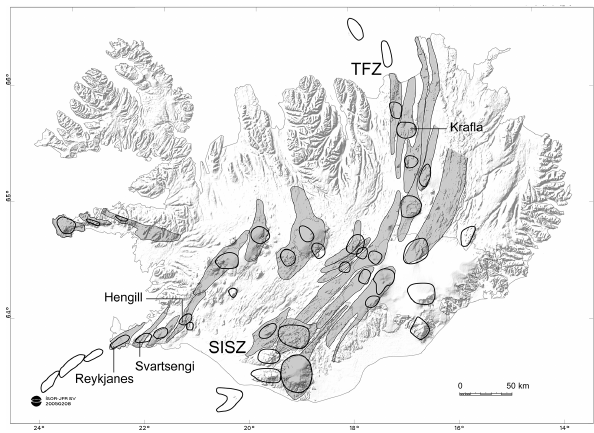
Figure 1. The location of rifting (shaded) in the neovolcanic zone of Iceland, an extension of the Mid-Atlantic Ridge. The map shows the location of the three high-enthalpy magma-hydrothermal systems – Krafla, Hengill, and Reykjanes – that are sites that were chosen for deep drilling by the Iceland Deep Drilling Project (IDDP). The irregular ellipses are active central